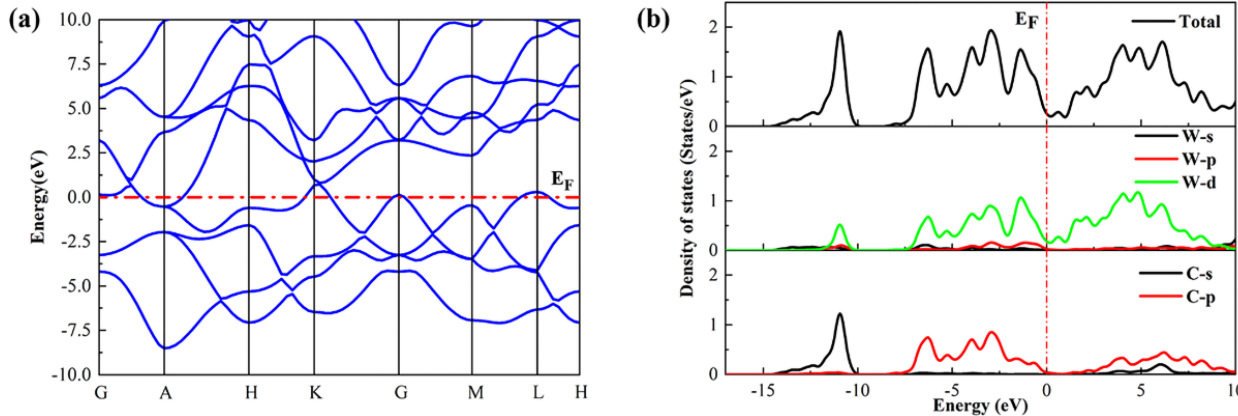
Figure 2. Calculated ( a ) bond structure and ( b ) DOS of WC bulk.